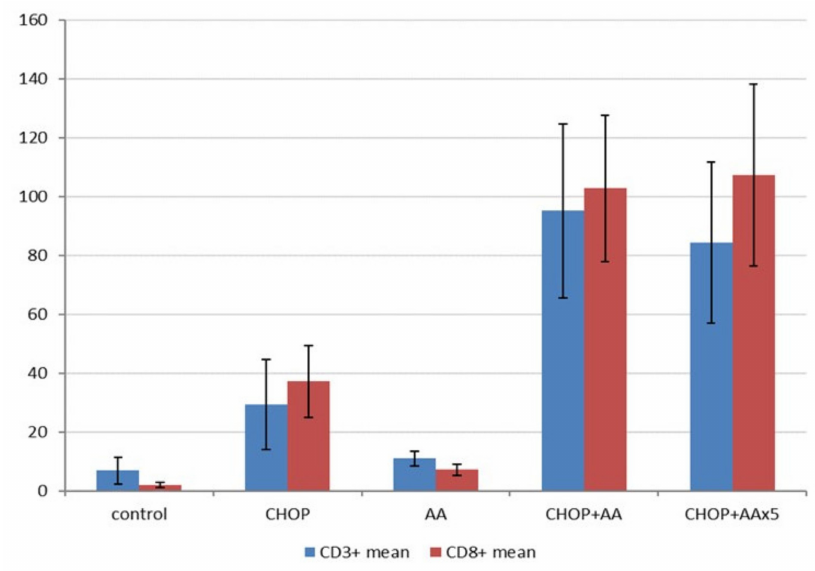
Figure 6. Results on T-cell infiltrates determined by immunohistochemistry in A20 lymphomas following di ff erent treatment combinations (Y-axis represents mean counts / high-power field). CD3 + (left columns) and CD8 + counts (right columns) changed in parallel. Treatment by CHOP alone resulted in a significant increase in the immune infiltrate ( p < 0.05), which was strongly intensified by the adjuvant AA treatment ( p < 0.05 for both values). Extended AA (AAx5) did not further improve the extent of lymphocytic infiltration ( p = 0.188 and